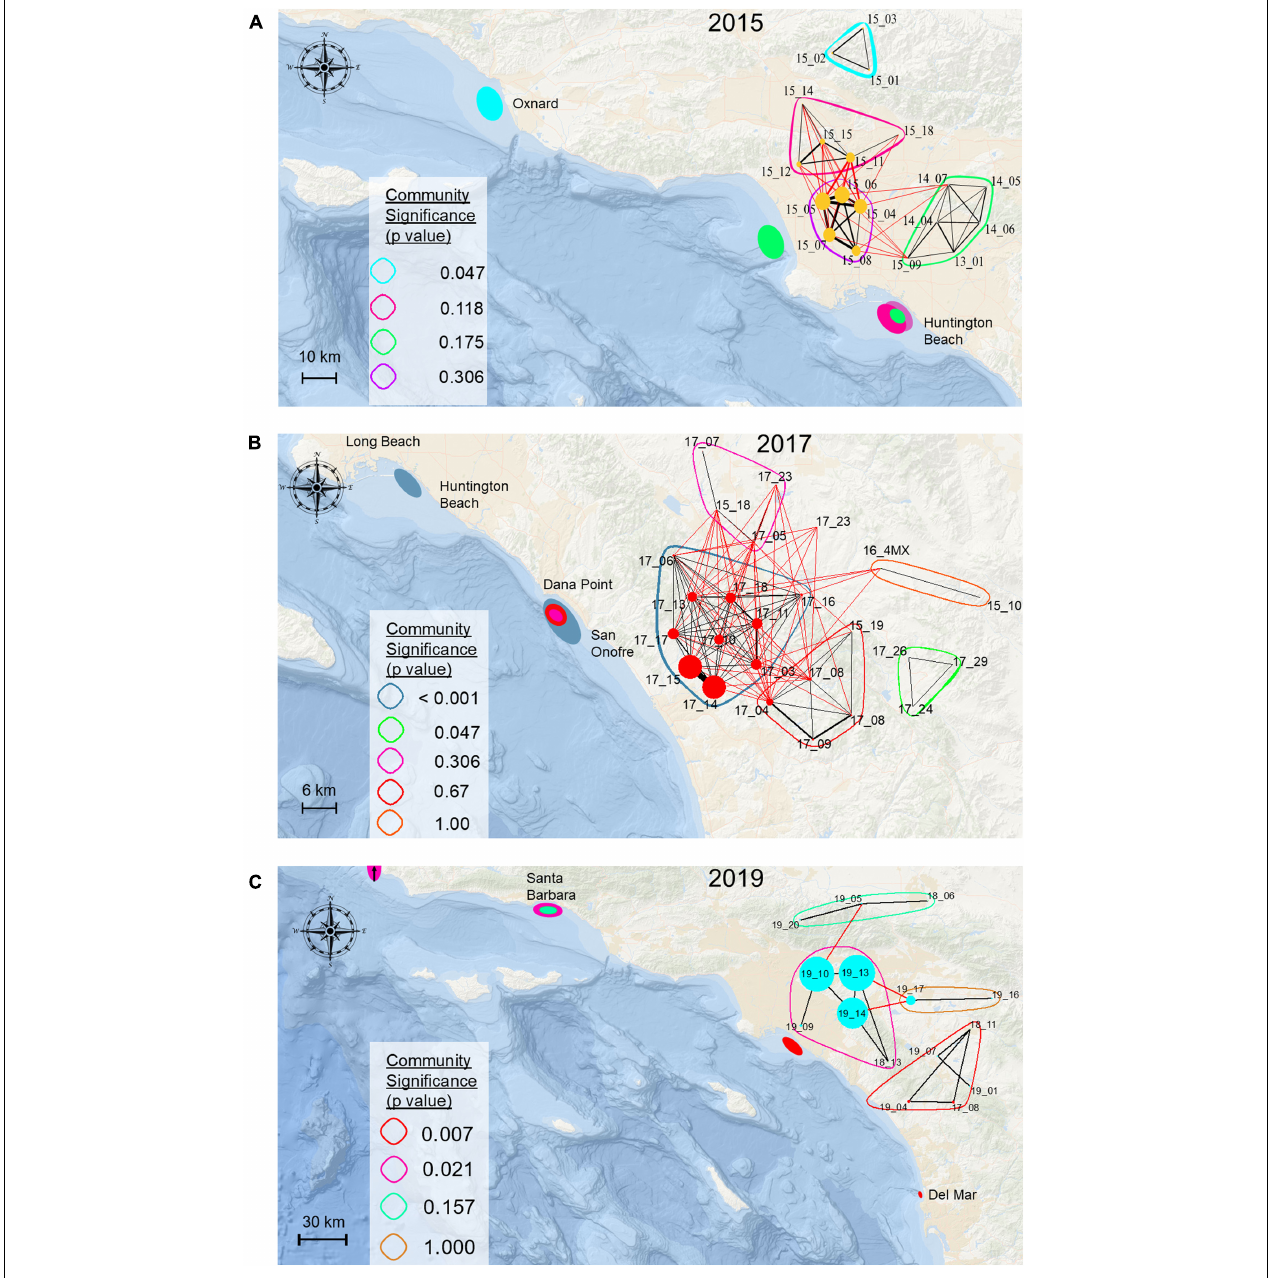
FIGURE 4 | Maps depicting community modularity in observed networks for 2015 (A) , 2017 (B) , and 2019 (C) . Community composition and corresponding discrete spatial locations of specific network communities are reflected in coloration of bands surrounding network nodes, and oval shaped markers within map coastal